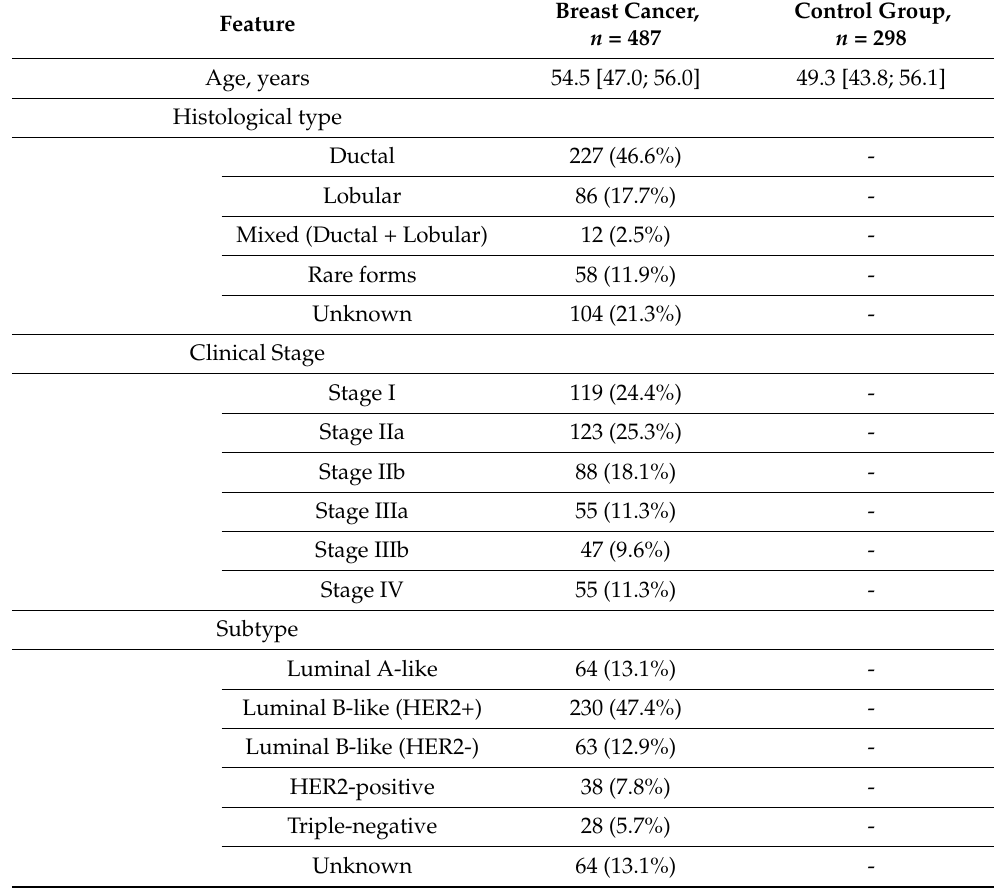
Table 5. The structure of the study